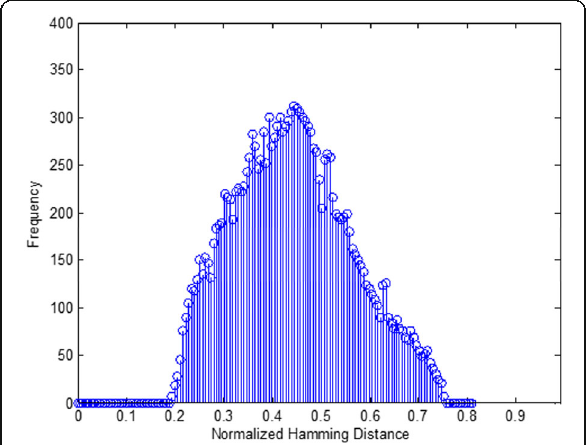
Fig. 8 The histogram of the normalized hamming distance for different image pairs